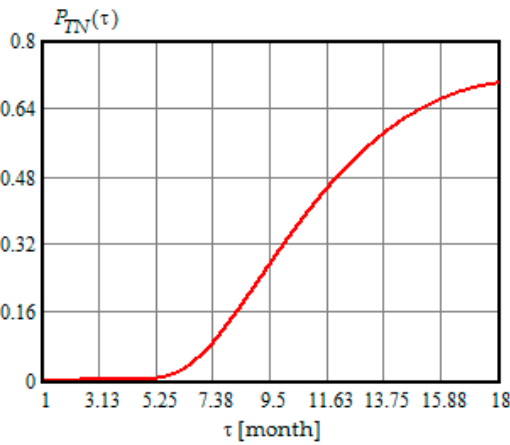
Figure 8. The dependence of the probability of false negative on the length of the interval τ .